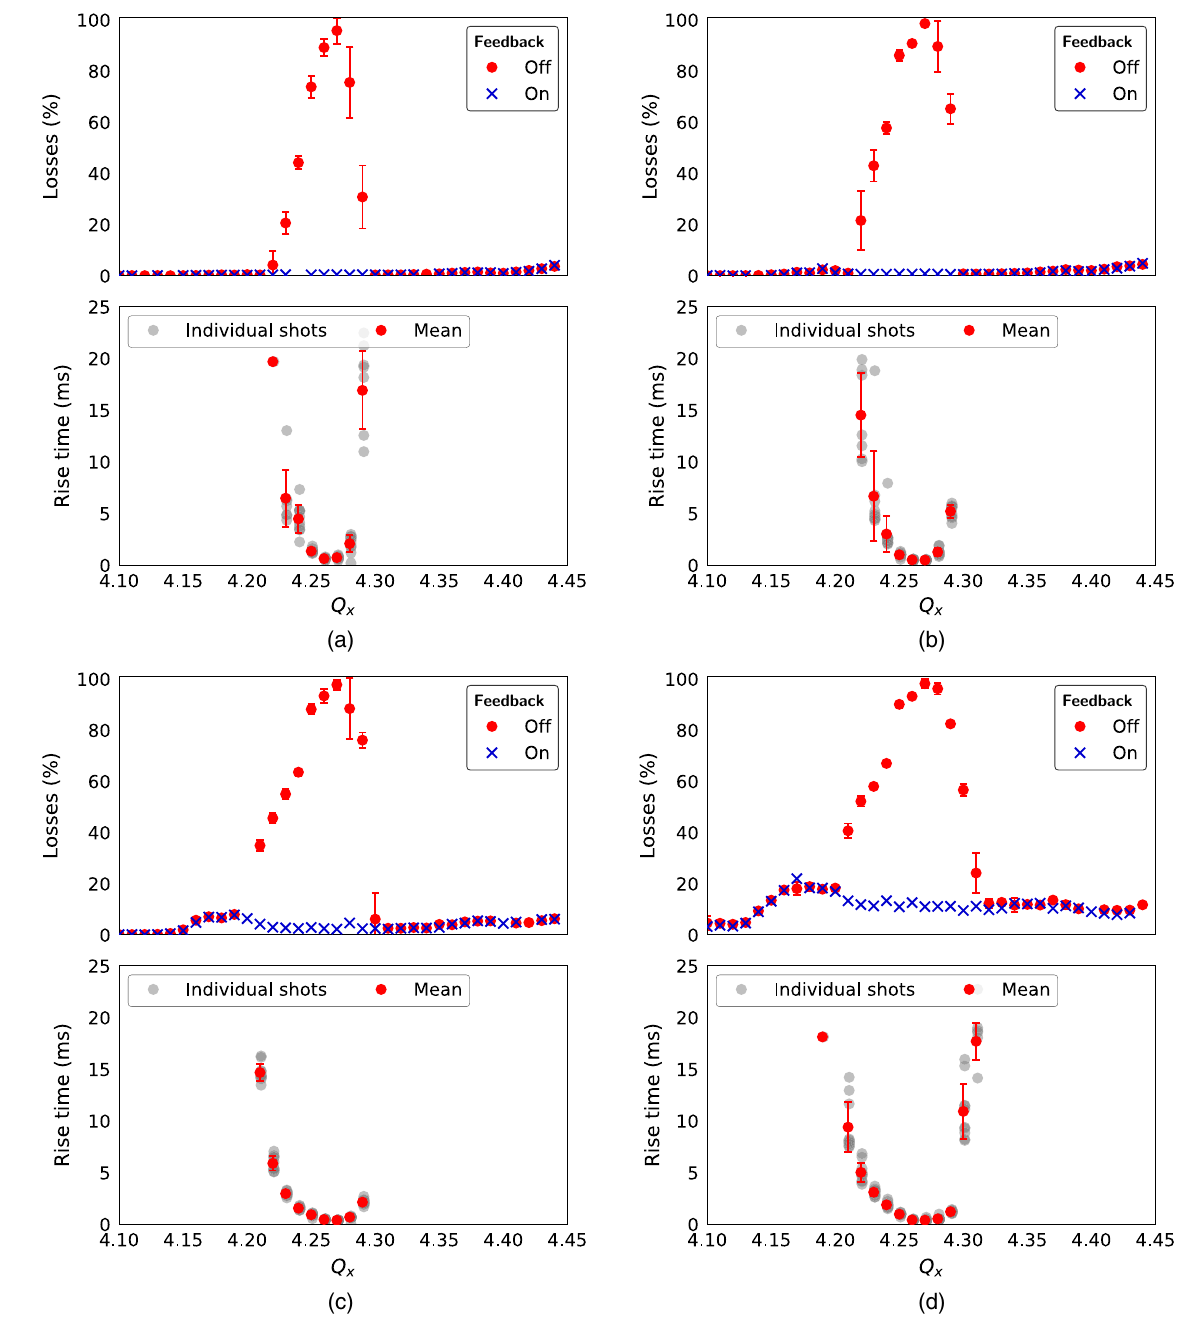
FIG. 4. Measured beam losses and rise times versus Q x at different intensities. Losses due to the instability are triggered for Q x between 4.23 and 4.30 for lower intensities and between 4.21 and 4.30 for higher intensities. The rise time becomes faster and faster as the tune increases from 4.20 and becomes slower again as we move away from Q x ¼ 4 . 26 . The error bars are given by the standard deviations of the individual acquisitions. When the TFB is on, it can successfully suppress the instability (blue crosses). As the intensity increases, additional losses start to appear due to incoherent effects. For example, for Q x ∼ 4 . 18 the losses are due to the coupling resonance. As expected, the incoherent losses due to the resonance crossing are present also when the TFB is on. (a) N ¼ 3 × 10 12 p, (b) N ¼ 4 × 10 12 p, (c) N ¼ 5 × 10 12 p and (d) N ¼ 6 × 10 12